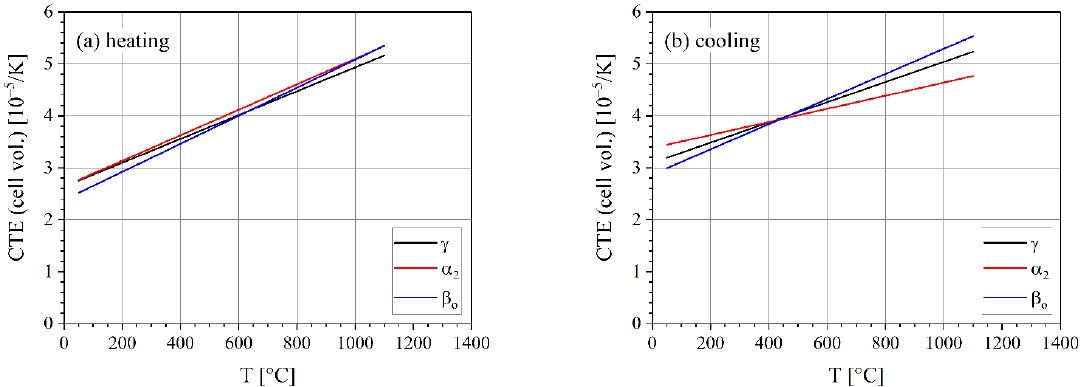
Figure 9. Coefficient of thermal expansion of the lattice volume for the three phases during heating ( a ) and during cooling ( b ) at a rate of 20 K min –1 .